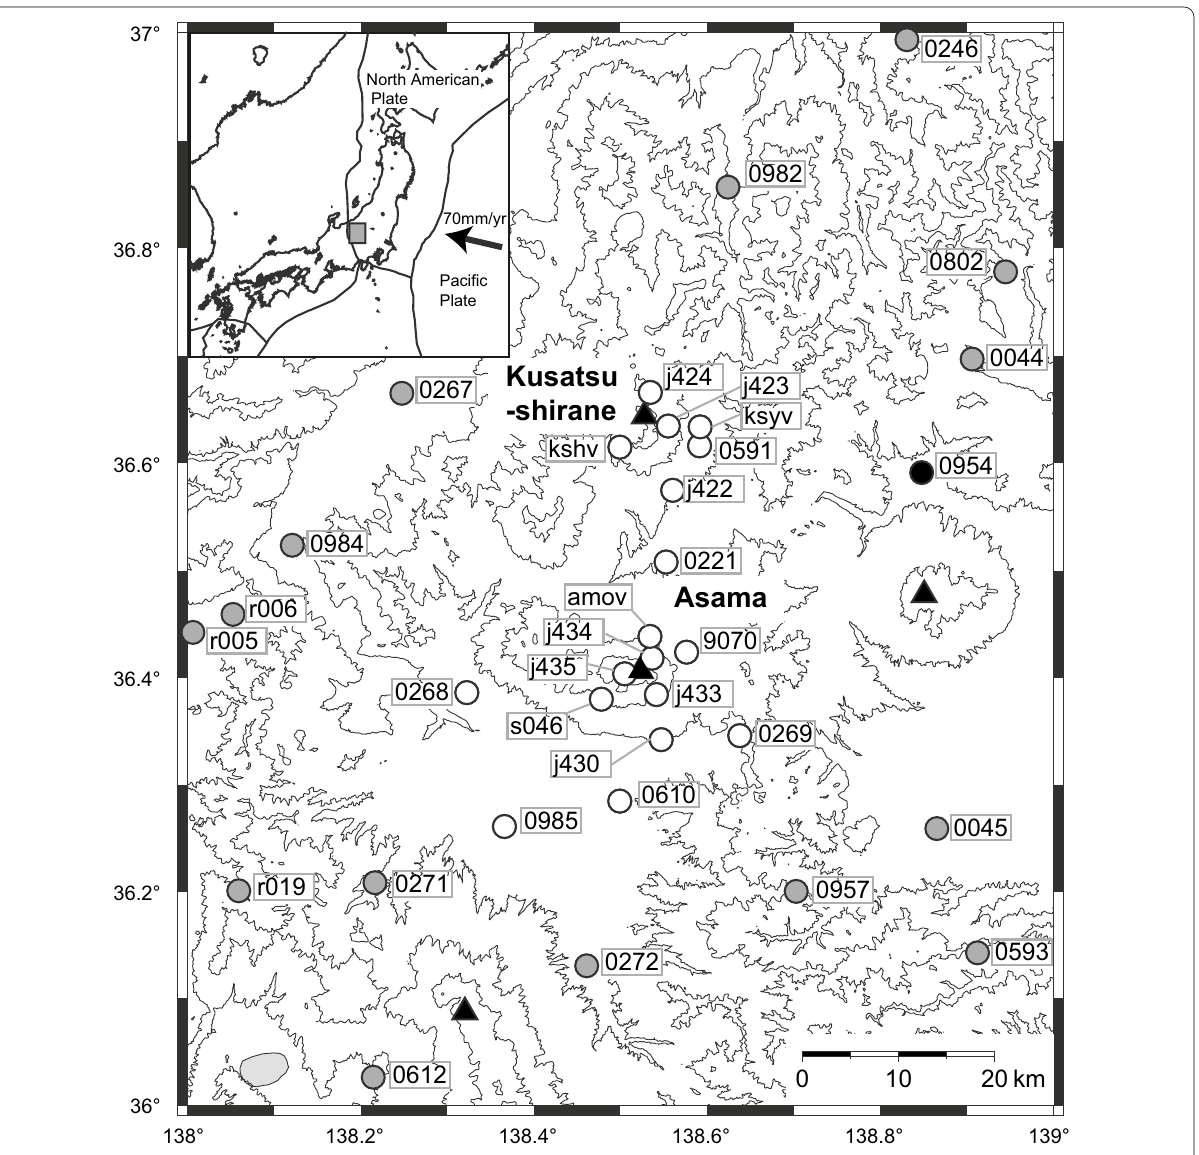
Fig. 1 Location of the studied area and distribution of GNSS observation sites. Inset shows the study area. The arrow shows the approximate motion of the Pacific Plate with respect to the North American Plate calculated using the NNR-Morvel 56 model (Argus et al. 2011). Active volcanoes are shown as triangles. Circles represent GNSS sites used in the study. Gray circles are those more than 20km away from Kusatsu-Shirane and Asama volcanoes that are used to estimate parameters representing tectonic